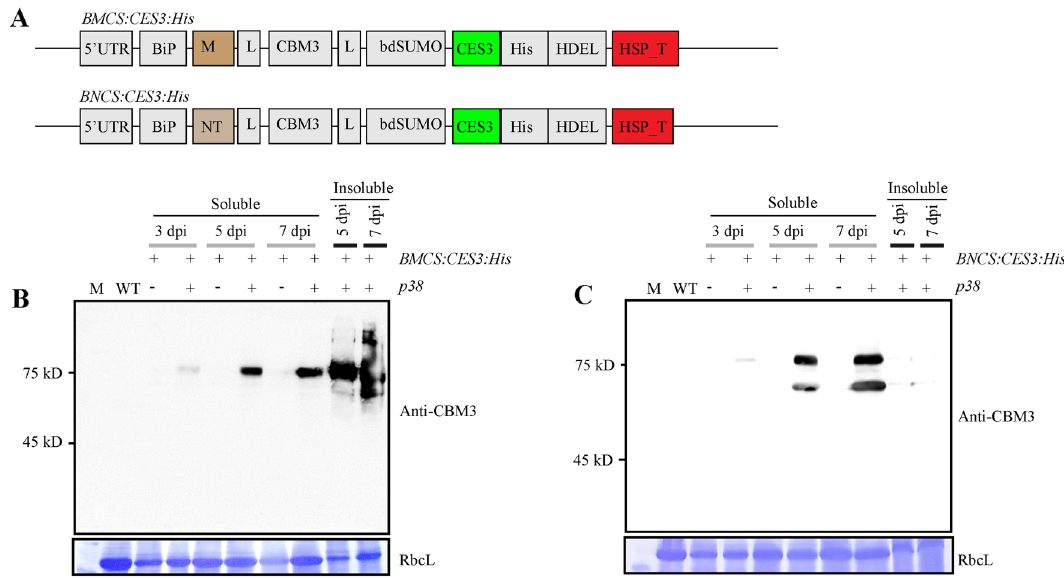
Figure 1. Expression of CES3-containing recombinant protein in Nicotiana benthamiana . ( A ) Schematic presentation of CES3-containing recombinant genes. BiP, the leader sequence of Arabidopsis BiP1; M, ectodomain (aa residues from Ala231 to Asp290) of human protein tyrosine phosphatase receptor type C (CD45); CBM3, cellulose-binding module 3; bdSUMO, Brachypodium SUMO; CES3, the N-terminal region containing cysteine-rich, EGF-like, and suchi 1–3 domains of Factor C from Carcinoscorpius rotundicauda ; 5’-UTR, a translation enhancing 5’ UTR; NT-m, N-terminal region of spider silk major ampullate